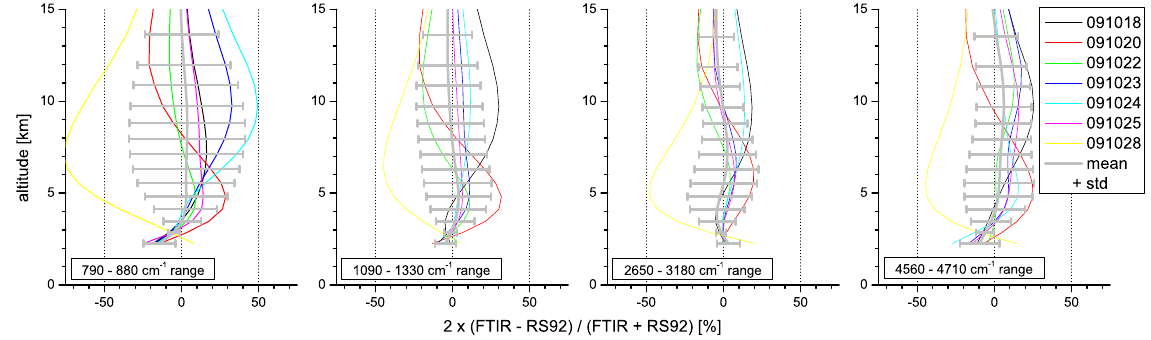
Fig. 12. Difference between coincident FTIR and smoothed RS92 H 2 O profiles for the retrievals in the four spectral regions. Coloured lines: individual coincidences; Thick grey line and error bars: mean and standard deviation.